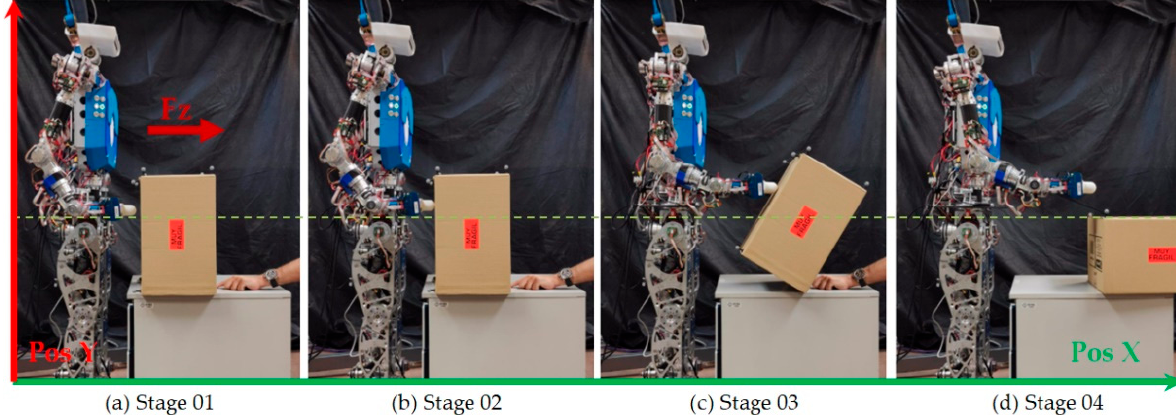
Figure 7. Experiment to check the overturning movement. Stages 01 to 04 are represented in the figures ( a – d ).